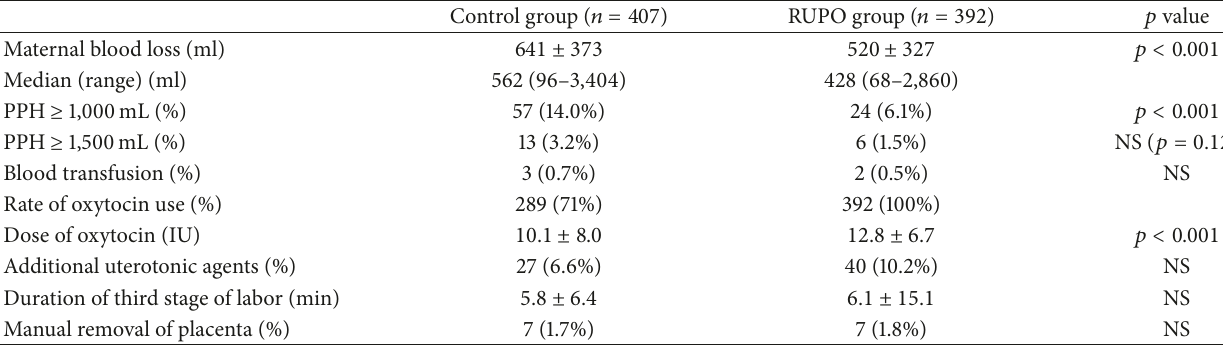
Table 2: The main outcomes and other factors associated with